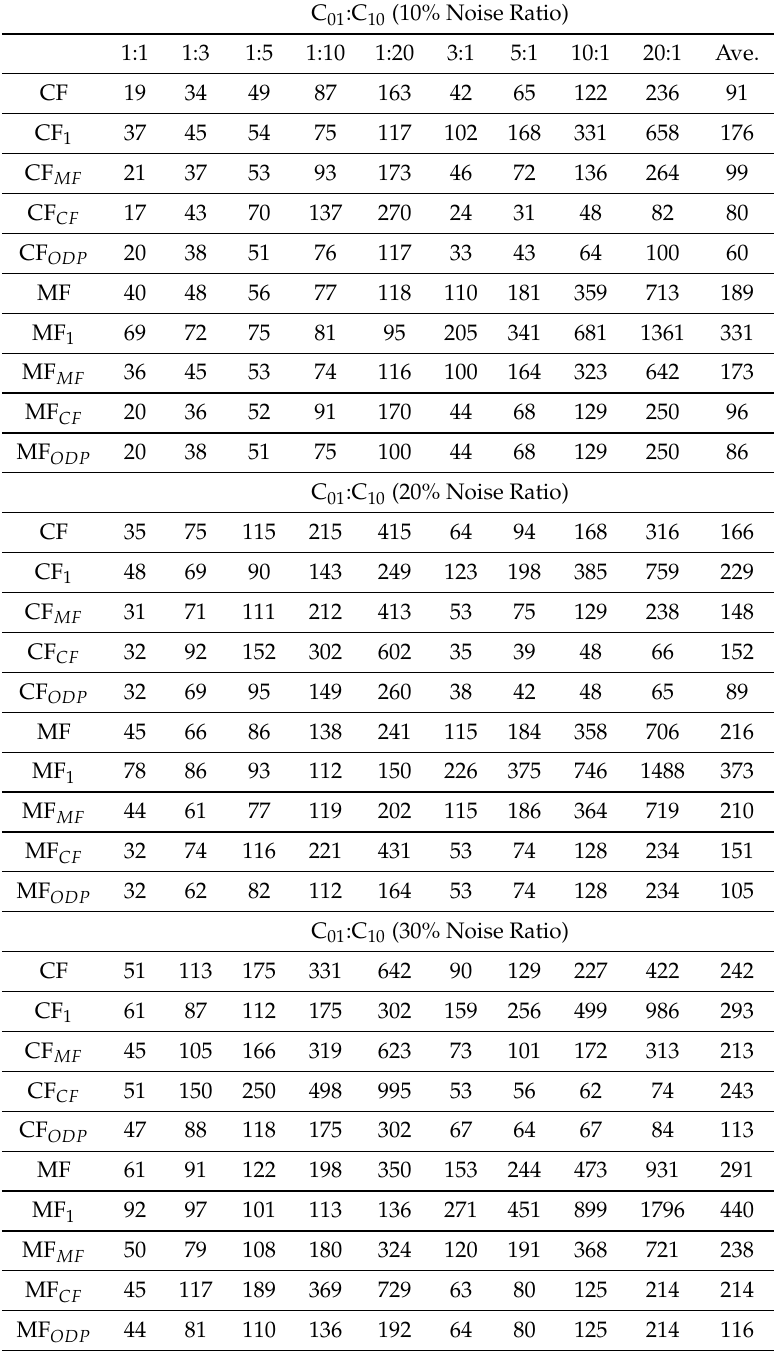
Table 12. Cost comparisons on Spect in the case that the noise ratio and noise-free dataset are